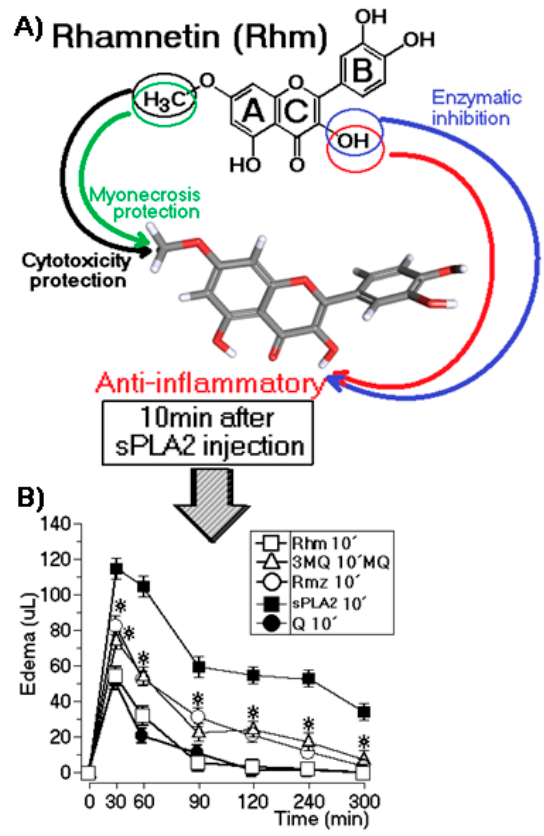
Figure 3. Structure-function relation between molecular regions of Rhm and its activities. ( A ) Molecular structure of Rhm in which the 3-OH in the C ring should lead to enzymatic and pharmacological inhibition and OCH 3 in the A ring should lead to cytotoxic and myotoxic protection; ( B ) Flavonol injection after 10 min of sPLA2 application (10 µ g protein and 12.5 µ g compound). The results are expressed as the mean ± standard deviation ( n = 5), and the * means p < 0.05 using the ANOVA and Bonferroni a posteriori